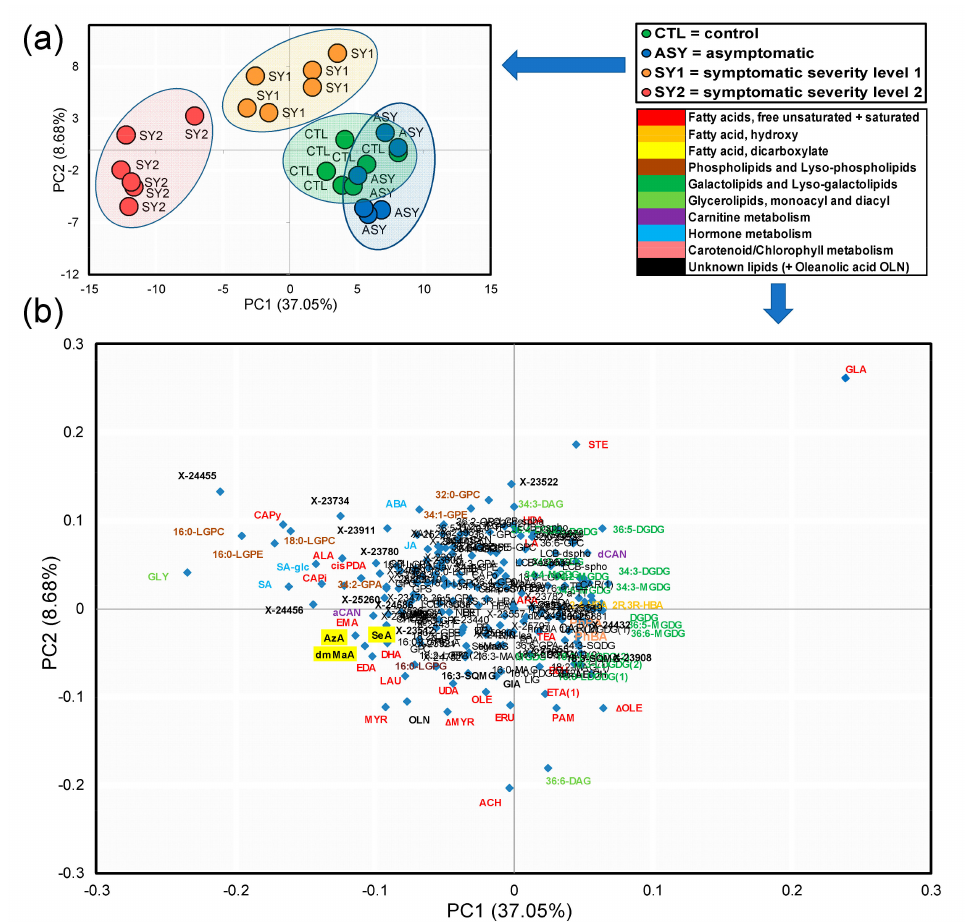
Figure 5. Principal component analysis (PCA) of lipidome data (lipid species, hormones, and other compounds of the metabolism of lipids) of leaves of Vitis vinifera L. ‘Malvasia Fina’ a ff ected by Esca complex disease (ESCA). ( a ) Loading plot of the first two principal components explaining 45.73% of total data variance. Four-Leaf groups were separated, as shown in the legend on the right. ( b ) Score scatter plot showing lipid species that strongly contributed to group separation. Abbreviations correspond to compounds in Table